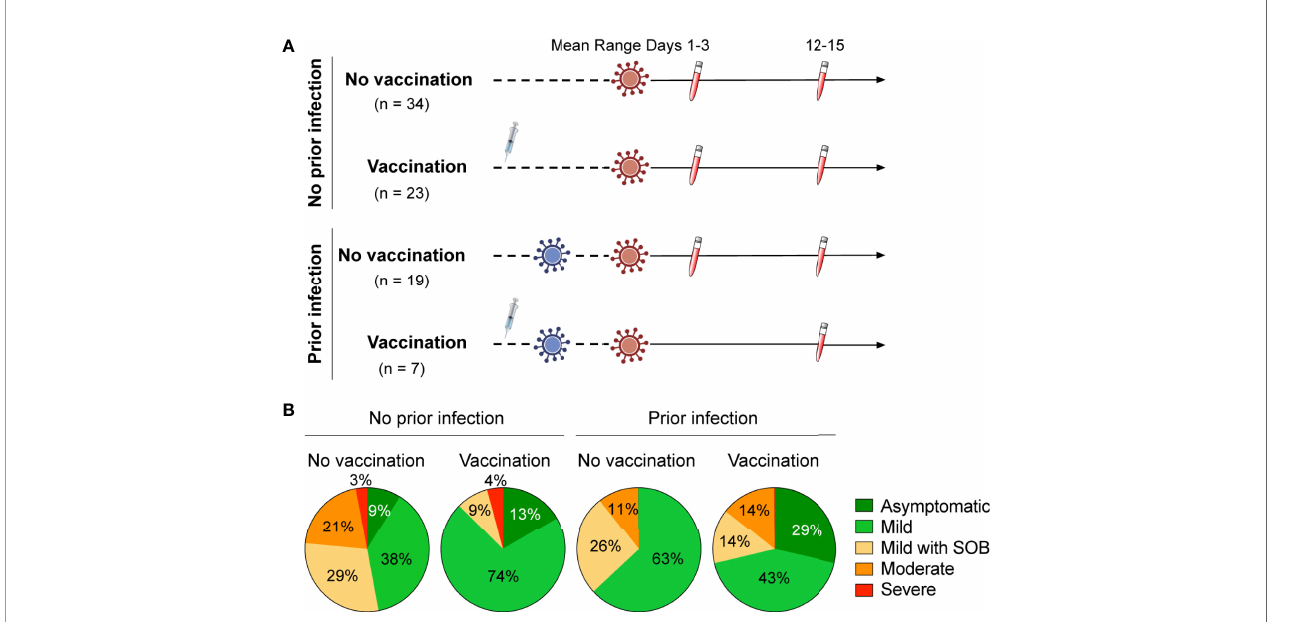
FIGURE 1 | Study design and outpatient symptomology. (A) Schematic presentation of the experimental work fl ow. All 83 study subjects were infected by the SARS-CoV-2 Omicron variant with or without prior infection with another SARS-CoV-2 variant. Four groups were studied: no vaccination/no prior infection (n=34), vaccination/no prior infection (n=23), no vaccination/prior infection (n=19) and vaccination/prior infection (n=7) ( Table 1 ). Blood was collected from the outpatients from three groups at two timepoints and from the fourth group at one time point after testing PCR positive. The range of the means of the different groups are shown. (B) Symptomology of the study cohorts. SOB, shortness of